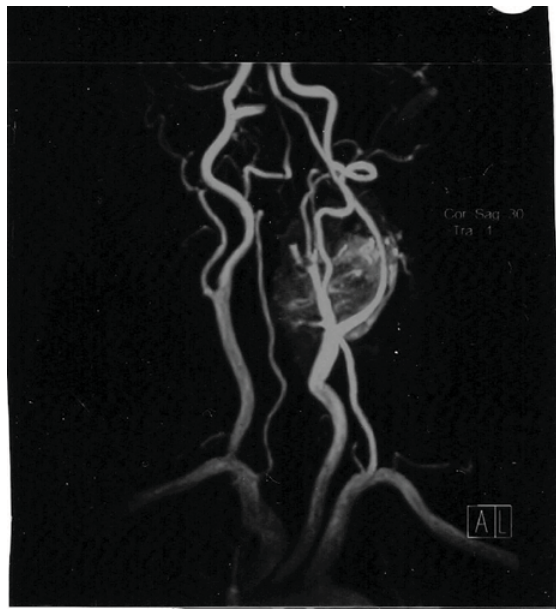
Figure 2. In MRI angiography, vascular tumor in carotid bifurcation.